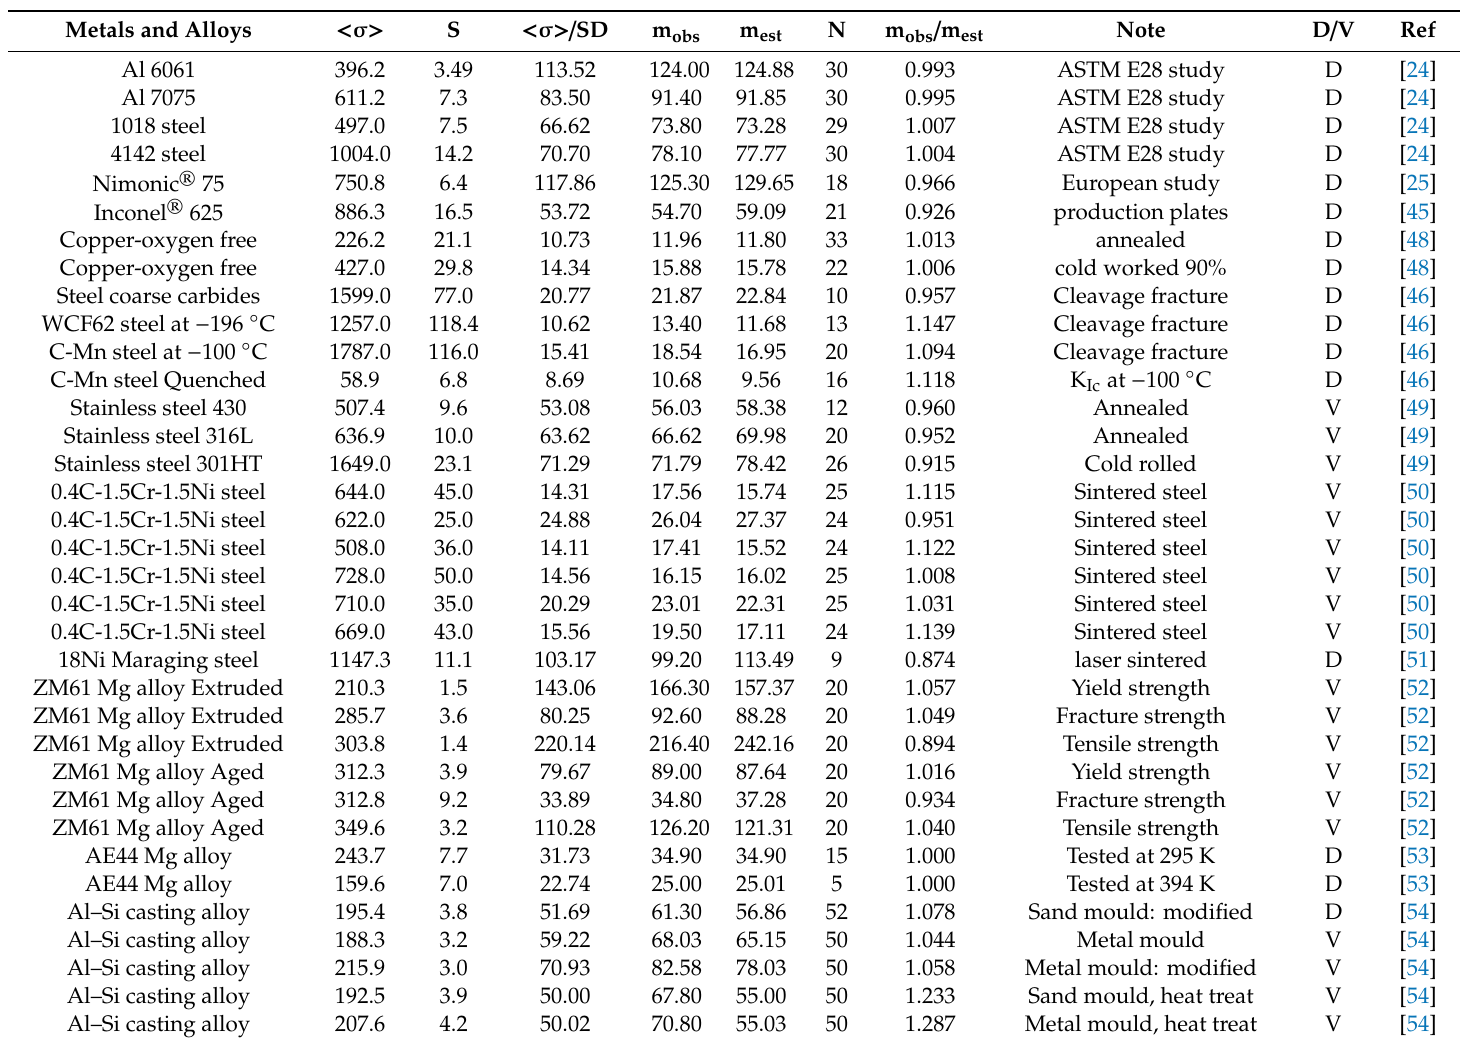
Table 3. Listing of data for metals and